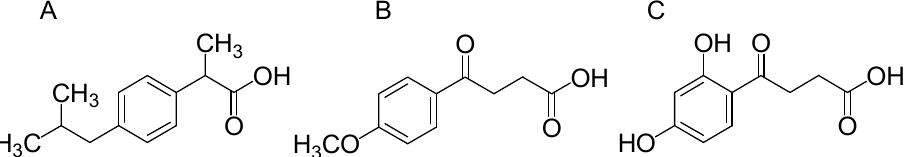
Figure 1. The 2D structures of the ligands used in this study: Ibuprofen ( A ); 4-(4-methoxyphenyl)-4-oxobutanoic acid—MBPA ( B ), and 4-(2,4-dihydroxyphenyl)-4-oxobutanoic acid—DHBPA ( C ).